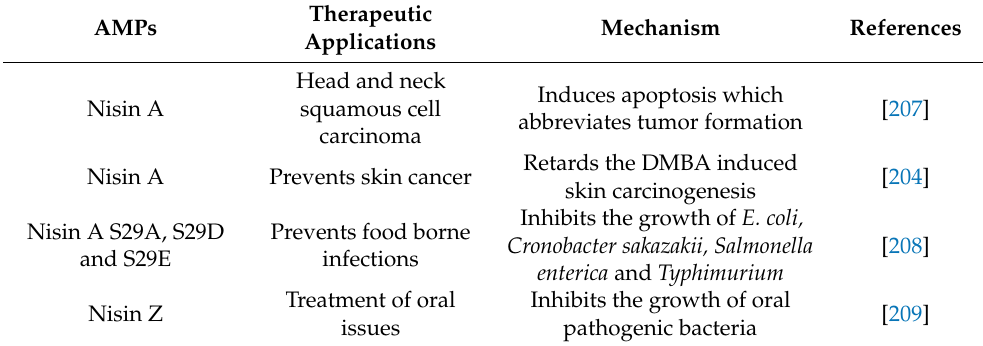
Table 9. Biomedical applications of nisin (AMPs derived from bacteria).